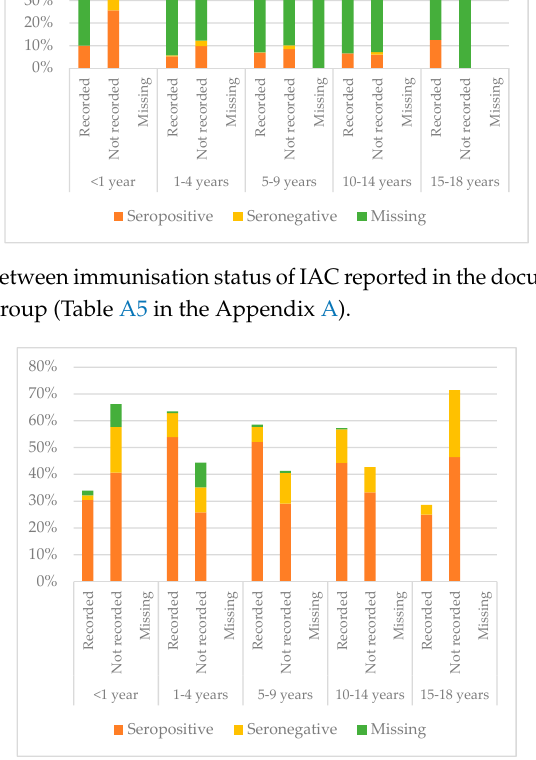
Figure 9. Comparison between immunisation status of IAC reported in the documentation and serology for tetanus, by age group (Table A6 in the Appendix A).